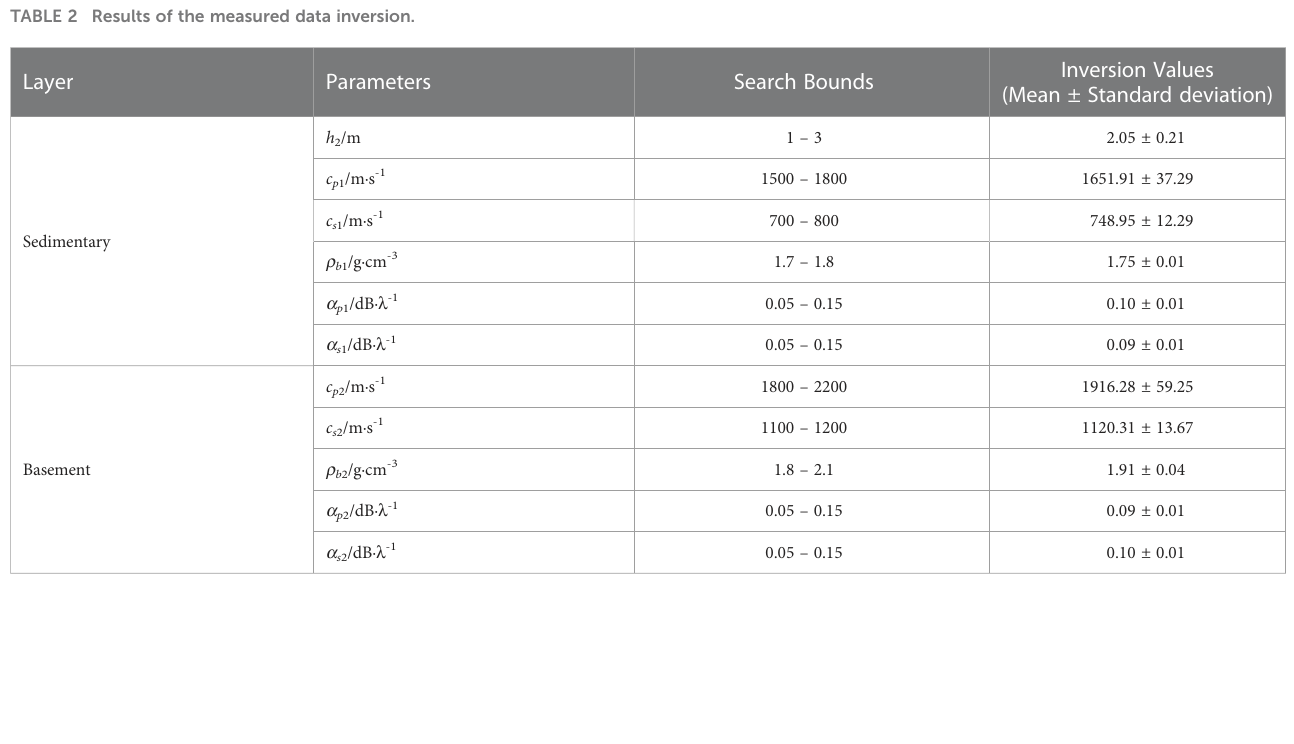
TABLE 2 Results of the measured data inversion.